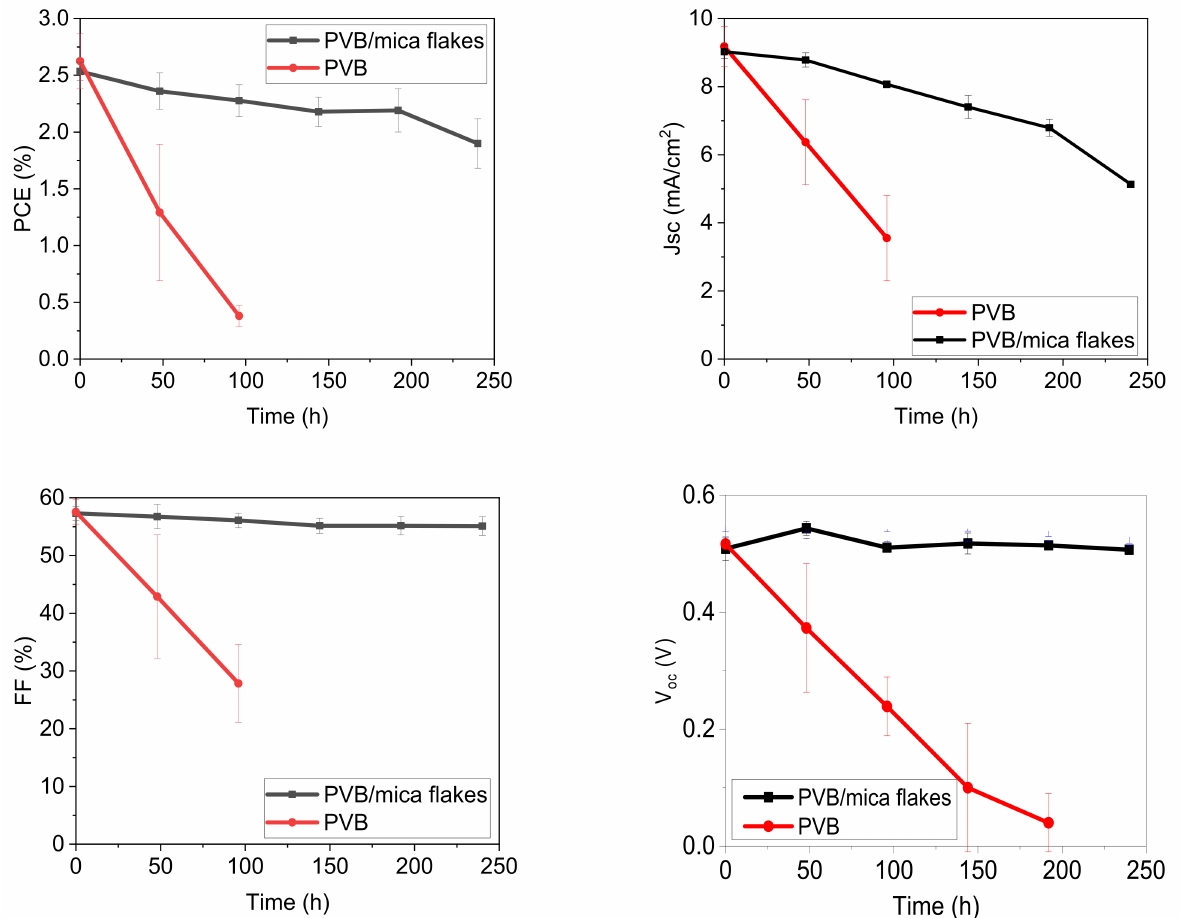
Figure 9. Sun degradation test of P3HT:PCBM-based solar cells encapsulated in barrier films, each having thickness of 150 µ m: pristine PVB film and PVB film filled with 25 vol% of mica flakes (AR = 40). Jsc: short circuit current. Voc: open circuit current. FF: fill factor. PCE: power conversion